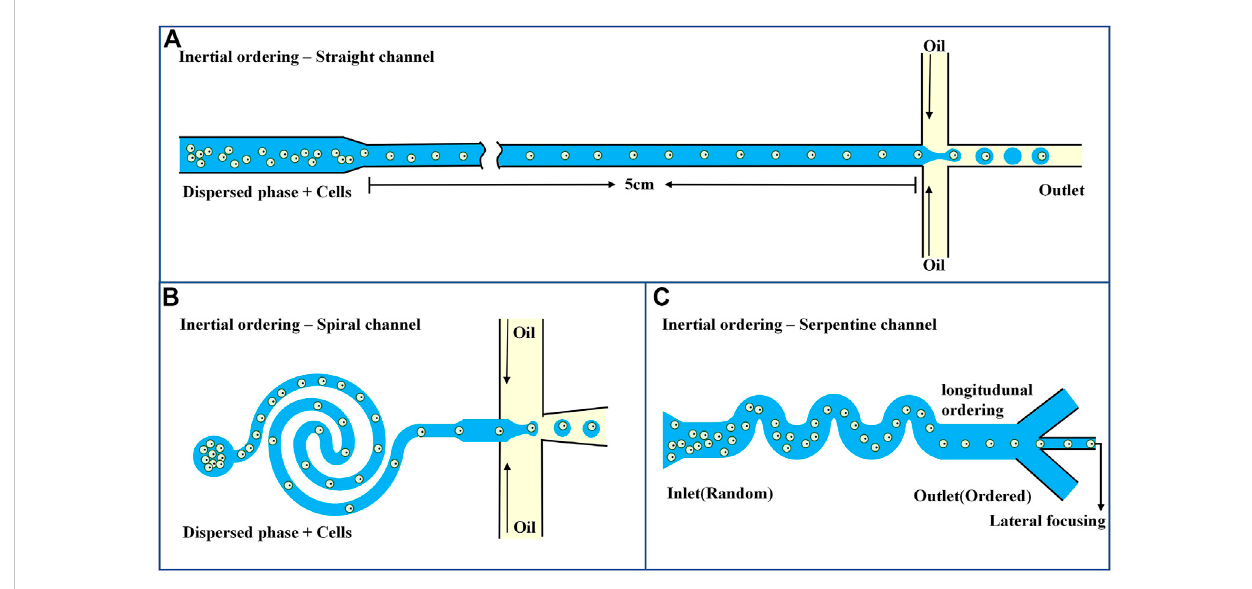
FIGURE 3 Micro fl uidics-based systems for single-cell focusing and encapsulation (A) Passive encapsulation of straight channel (Ling et al., 2020). (B) Passive encapsulation of spiral micro channel (Ling et al., 2020). (C) Passive encapsulation of serpentine channel (Li et al.,